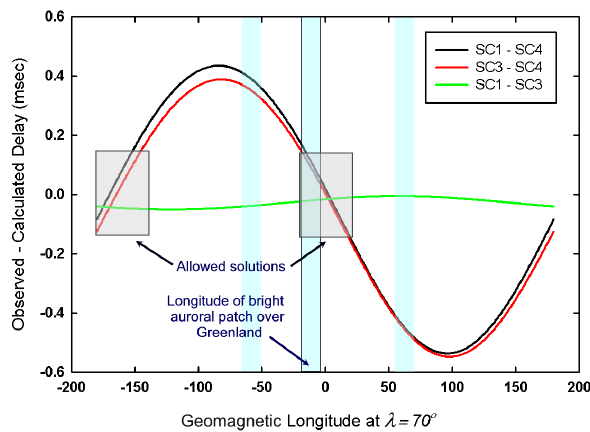
Fig. 16. The delay difference (observed minus calculated) for base- lines SC1–SC3, SC1–SC4, and SC3–SC4 versus ring longitude for the AKR emission event of 11 January 2001 at 20:55:42UT. The light blue strips are longitudes of auroral bright spots as seen on the Polar UVI image; the boxes are the allowed regions constrained by the observed delays and their uncertainties. There are two allowed longitude ranges, but only one (near − 20 ◦ longitude) is along a magnetic field line connected to a bright auroral spot. The AKR source is believed to be located within this